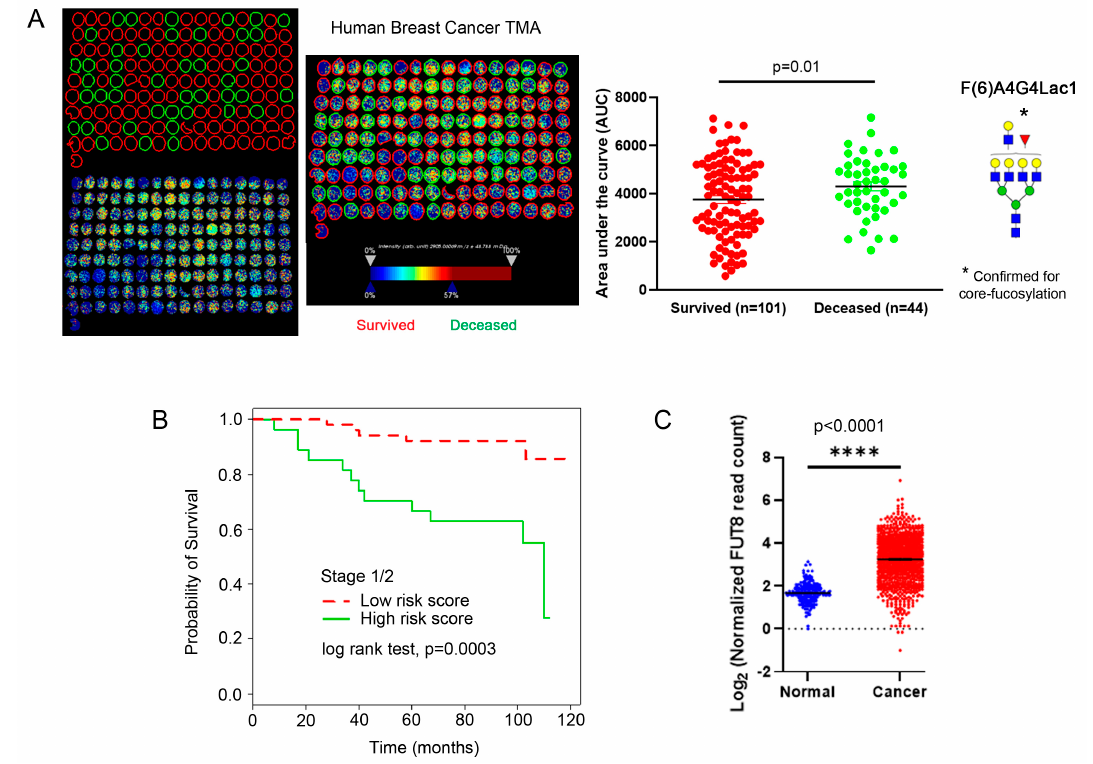
Figure 6. A validation of breast TMA with tumor cores from 145 patients. ( A ) MALDI-IMS of this TMA showing representative deceased (green circles) and survived (red circles) patients from stage 1 and 2 samples. Quantitation of each group shows that tumor samples from deceased patients had statistically significant higher levels of F(6)A4G4Lac1 than those from survived patients ( p = 0.01). ( B ) Patients with the higher signal of tetra-antennary with one lactosamine arm and one fucose (F(6)A4G4Lac1) correlate with higher risk and poor survival (measured in months). ( C ) Analysis of RNA expression of FUT8 from TCGA shows higher levels of FUT8 in cancer vs. normal patients. **** p < 0.0001.